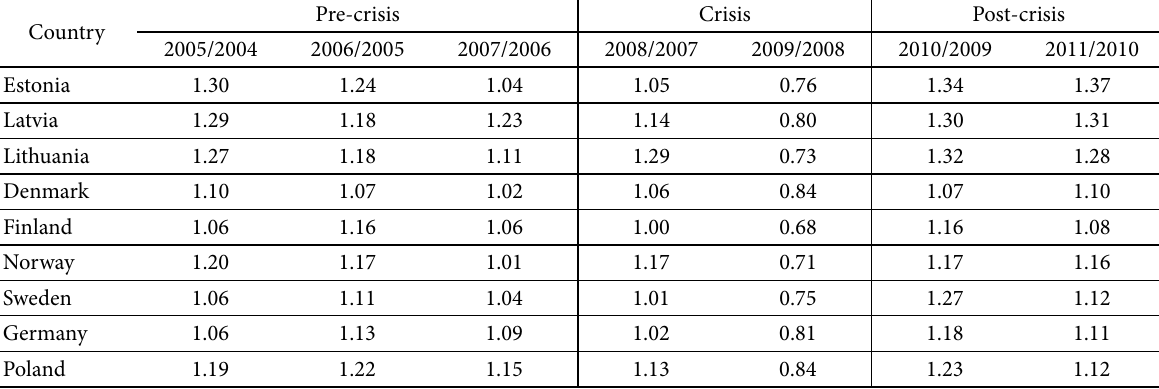
Table 1. Comparison of export volumes in the BSR countries in 2004–2011, % to a previous year (Eurostat 2013; OECD 2013)